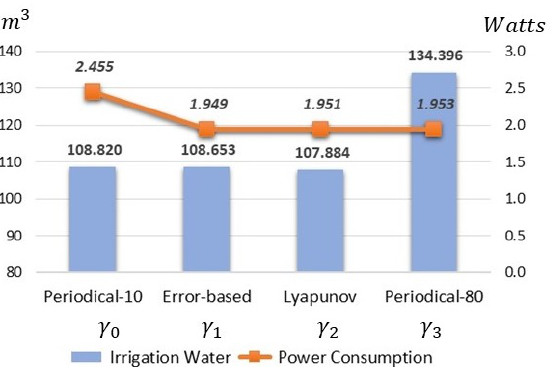
Figure 10. The estimated spent energy for the sensor nodes and water consumption for each irrigation